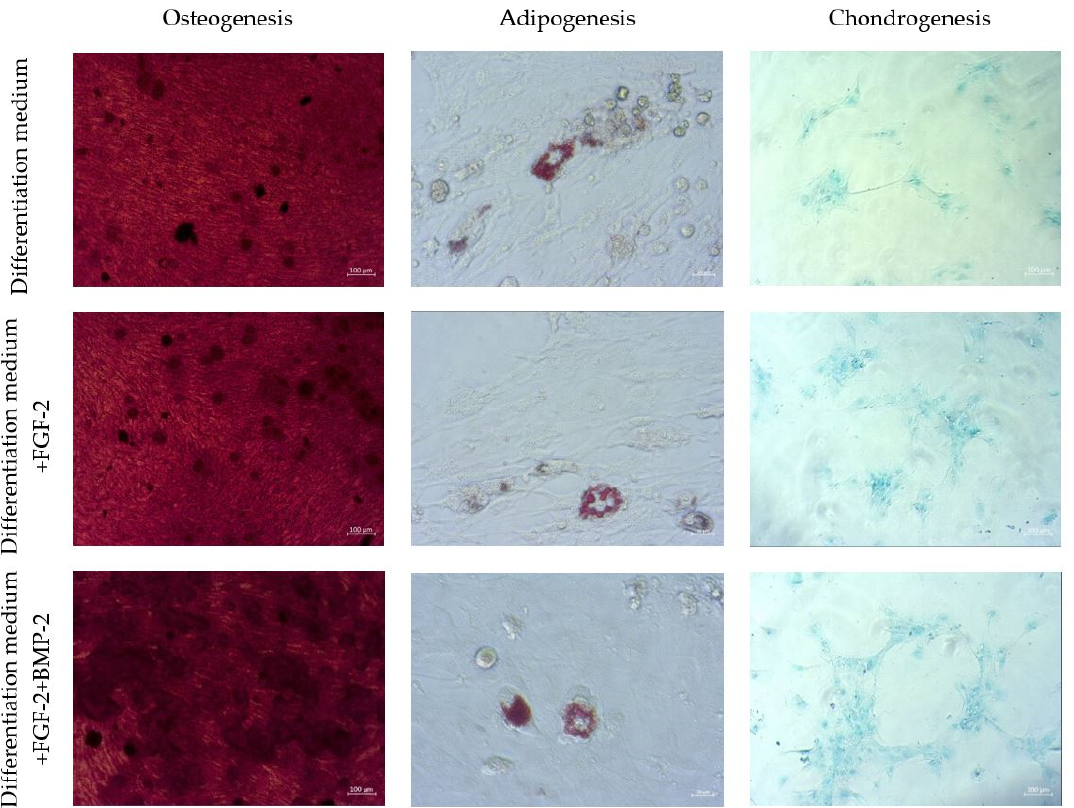
Figure 7. Multilineage differentiation of sheep BM-MSCs. Osteogenic differentiation was assessed using Alizarin Red S staining, adipogenic differentiation using Oil Red O, and chondrogenic differentiation using Alcian Blue staining.